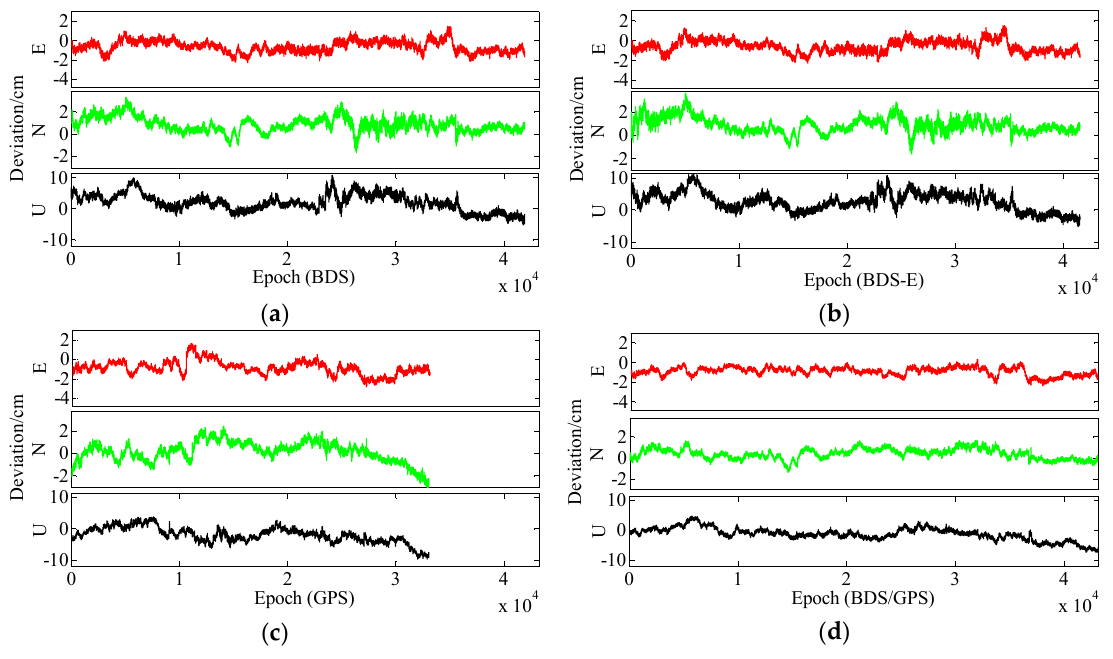
Figure 17. ENU deviations of four systems for group A. ( a ) ENU deviations of BDS for group A. ( b ) ENU deviations of BDS-E for group A. ( c ) ENU deviations of GPS for group A. ( d ) ENU deviations of BDS/GPS for group A.